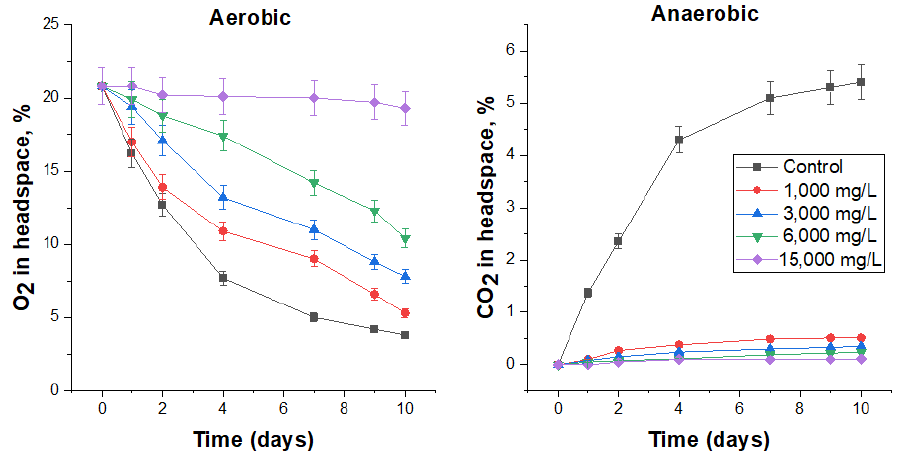
Figure 5. The effect of sodium percarbonate on O 2 consumption under aerobic conditions and CO 2 production under anaerobic conditions by the respective microbial communities in FS.